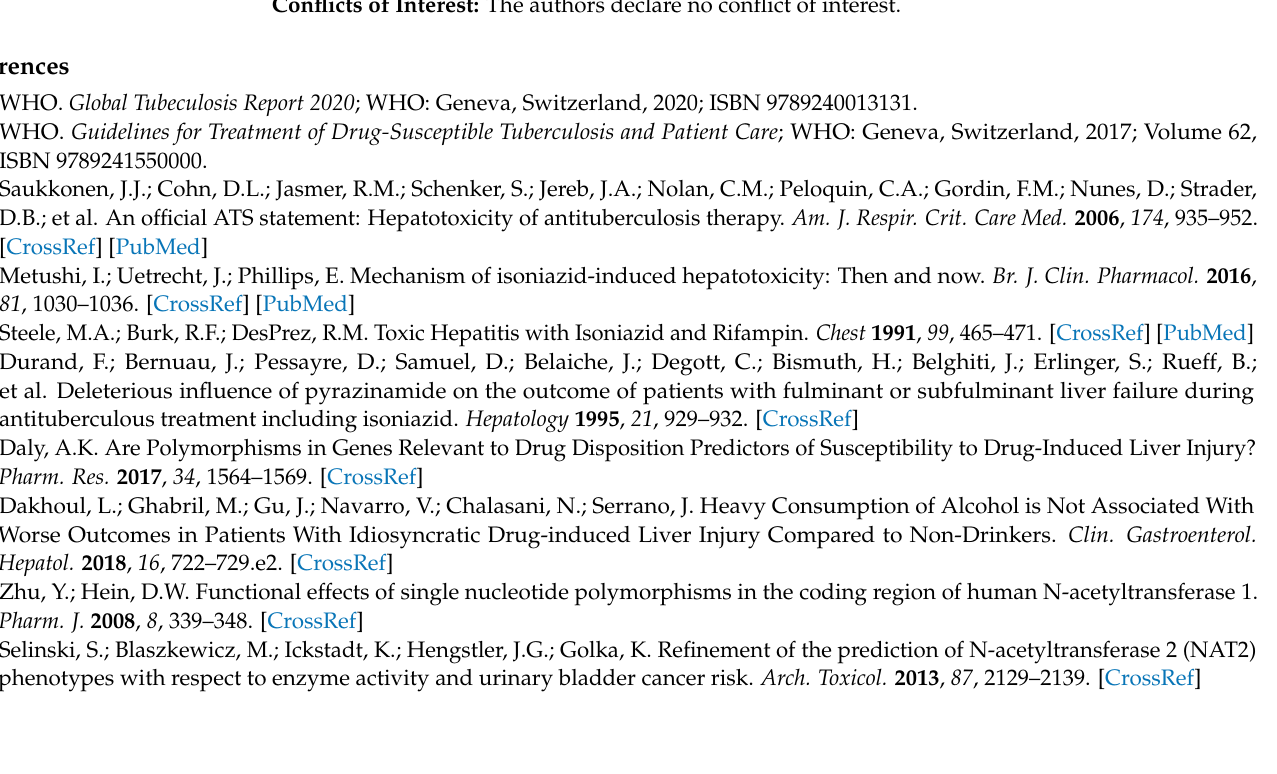
sequencing reactions; Table S2: Characterization of non-genetic risk factors in mild hepatitis and DILI; Table S3: Characterization of genetic risk factors in mild hepatitis and DILI; Table S4: Results of logistic multivariate analysis for mild